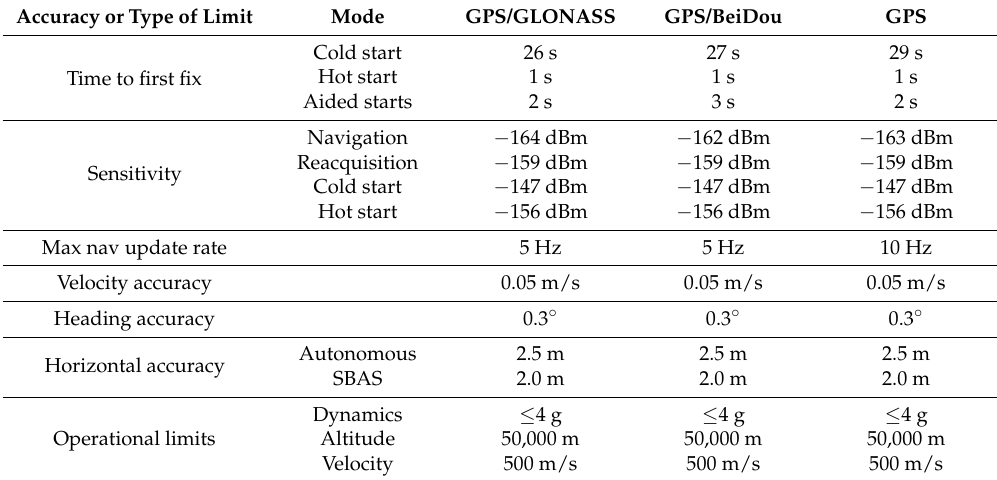
Table 2. “Ublox Neo-M8N” accuracy and limits for various operational